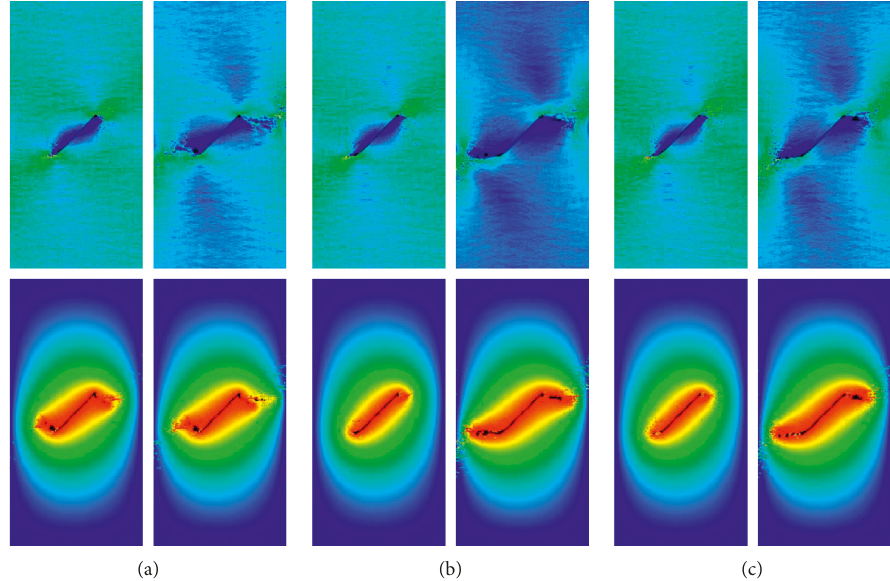
Figure 9: Maximum shear stress (upper) and pore pressure (lower) evolution diagram of different pore pressures when σ �